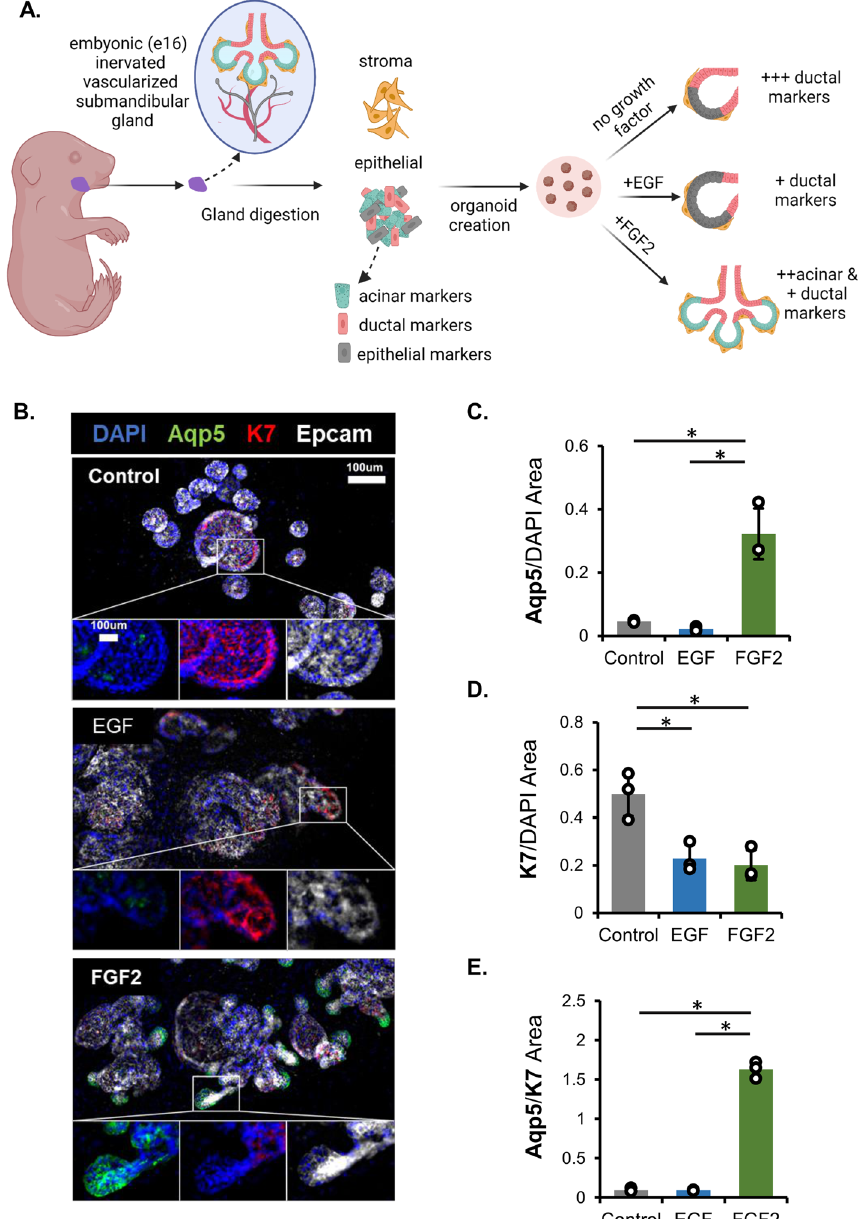
Fig. 1 FGF2 promotes proacinar and inhibits ductal differentiation in embryonic salivary gland organoids. A Illustration of salivary gland organoid creation from murine embryonic salivary gland cells, which are separated for regulated recombination in Matrigel. Keratin-7 (K7)-positive ductal cells are shown in red, aquaporin-5 (AQP5)-positive pro-acinar cells are shown in green, and mesenchymal stromal cells are shown in yellow. Created with Biorender.com. B Representative images show that, while all organoids express the pan-epithelial marker EpCAM (white) and some level of the ductal marker K7 (red), the elaboration of AQP5 + cells (green) is restricted to branched organoids treated with FGF2. Nuclei are stained with DAPI. ( C – E ) Quantification of microscopy images with relative area ratios for AQP5 to DAPI, K7 to DAPI, and AQP5 to K7. Error bar represents 95% confidence interval, n 3 technical replicates; asterisk indicates significance with = p < 0.05 (one-way ANOVA with Tukey’s post hoc test) (statistical summary in Additional file 1: Table